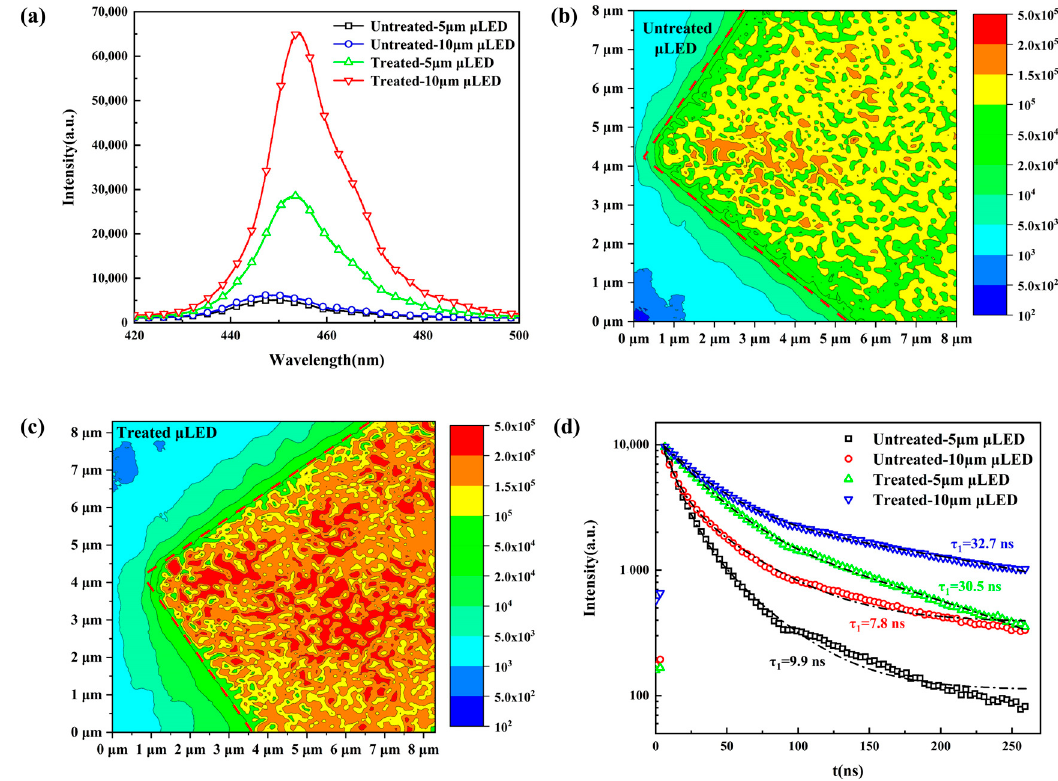
Figure 2. ( a ) PL spectra at room temperature; ( b ) PL mapping of 10 µ m untreated Micro-LED; ( c ) PL mapping of 10 µ m treated Micro-LED; and ( d ) time-resolved photoluminescence (TRPL) spectra at room temperature. The fitting curves are shown as black dot-dash lines in the